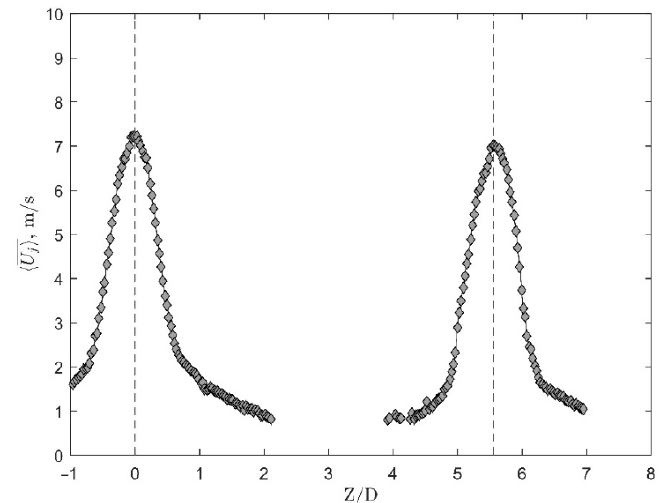
Figure 5. The mean jet velocity during the blowing stroke across two consecutive synthetic jet orifices (n = 8 and n = 9) for the excitation frequency f e = 1220 Hz. Velocity measurements are performed at one orifice diameter above the exit of the orifices (Y/D = 1). The excitation voltage is E = 150 V pp .